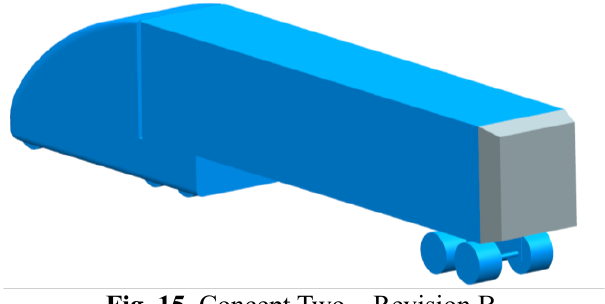
Fig. 15. Concept Two – Revision B.